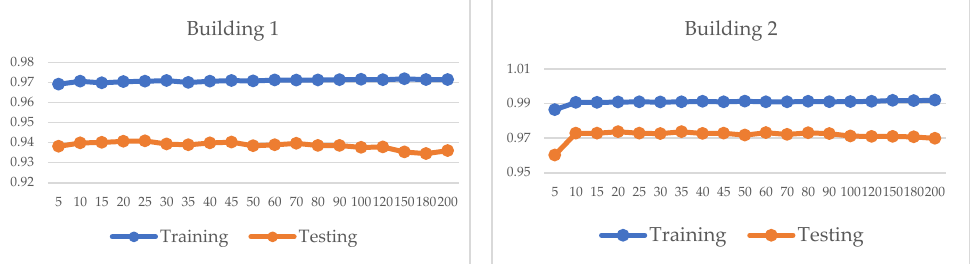
Figure 5. ANN model optimization for neuron numbers.